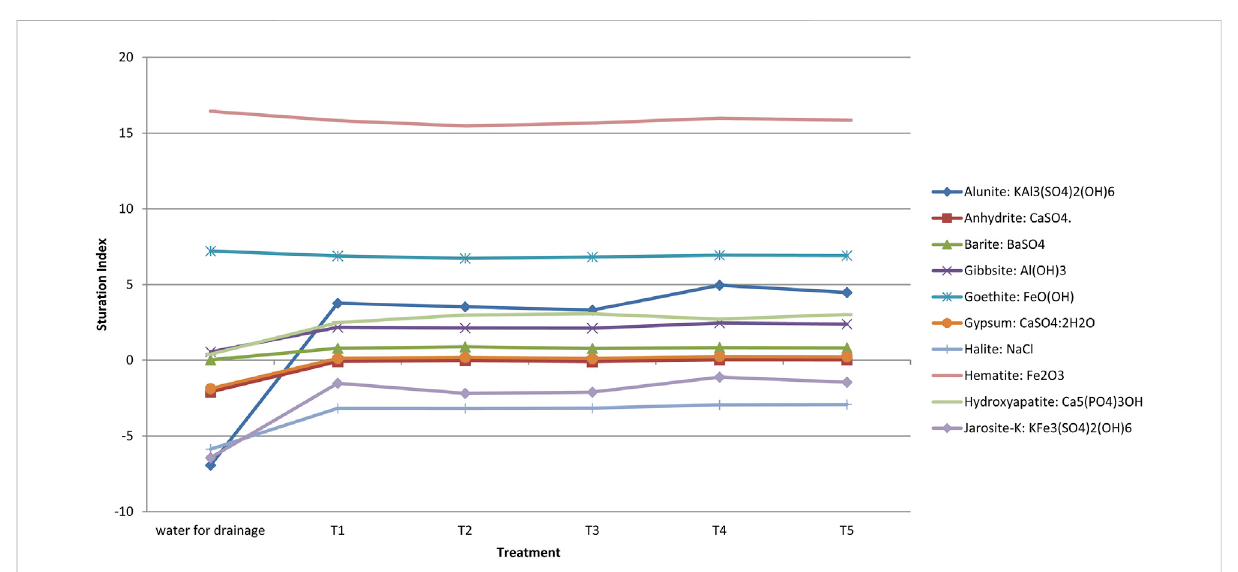
FIGURE 6 Saturation index of Sidi El Mokhtar soil leached